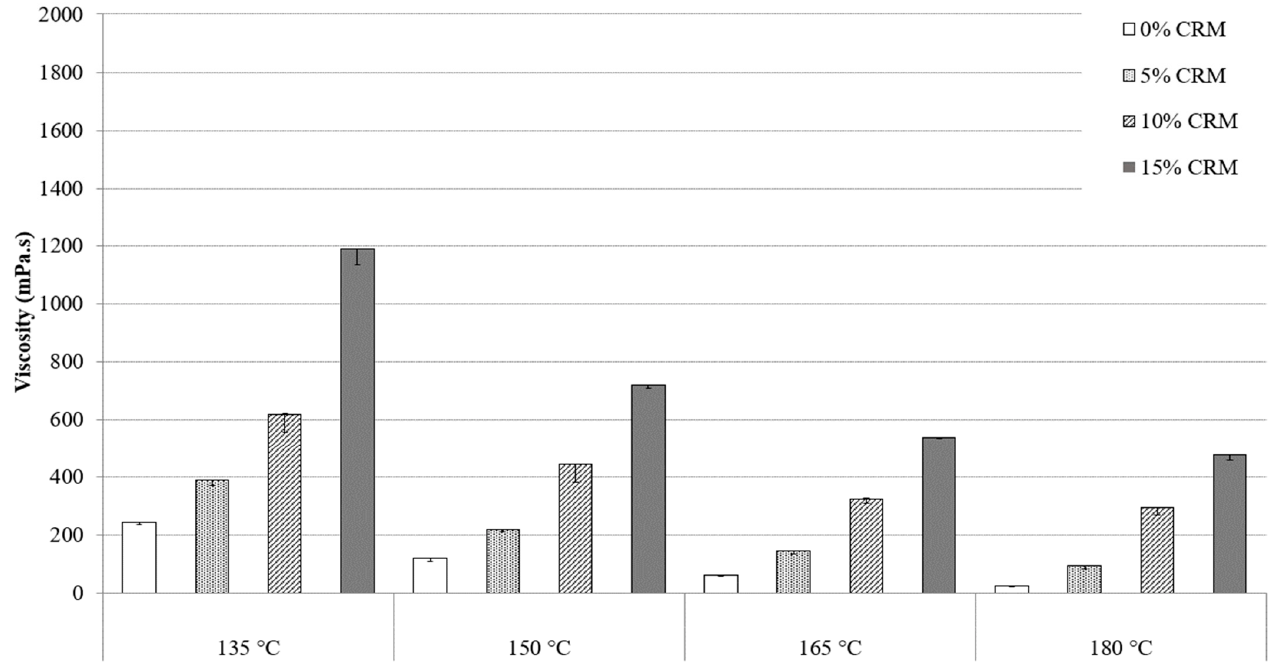
Figure 3. PG 64-22 viscosity binder with 12% processed oil as a function of CRM content.